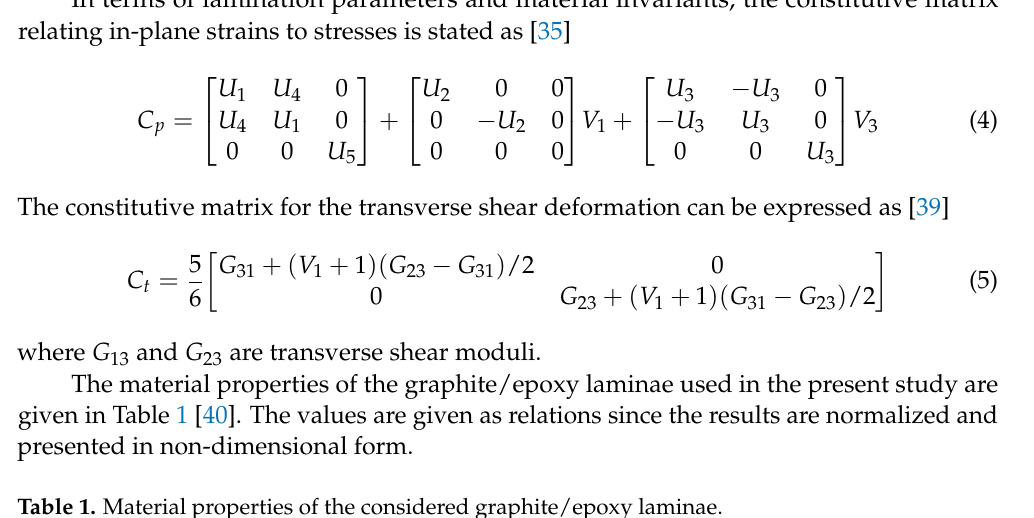
Table 1. Material properties of the considered graphite/epoxy